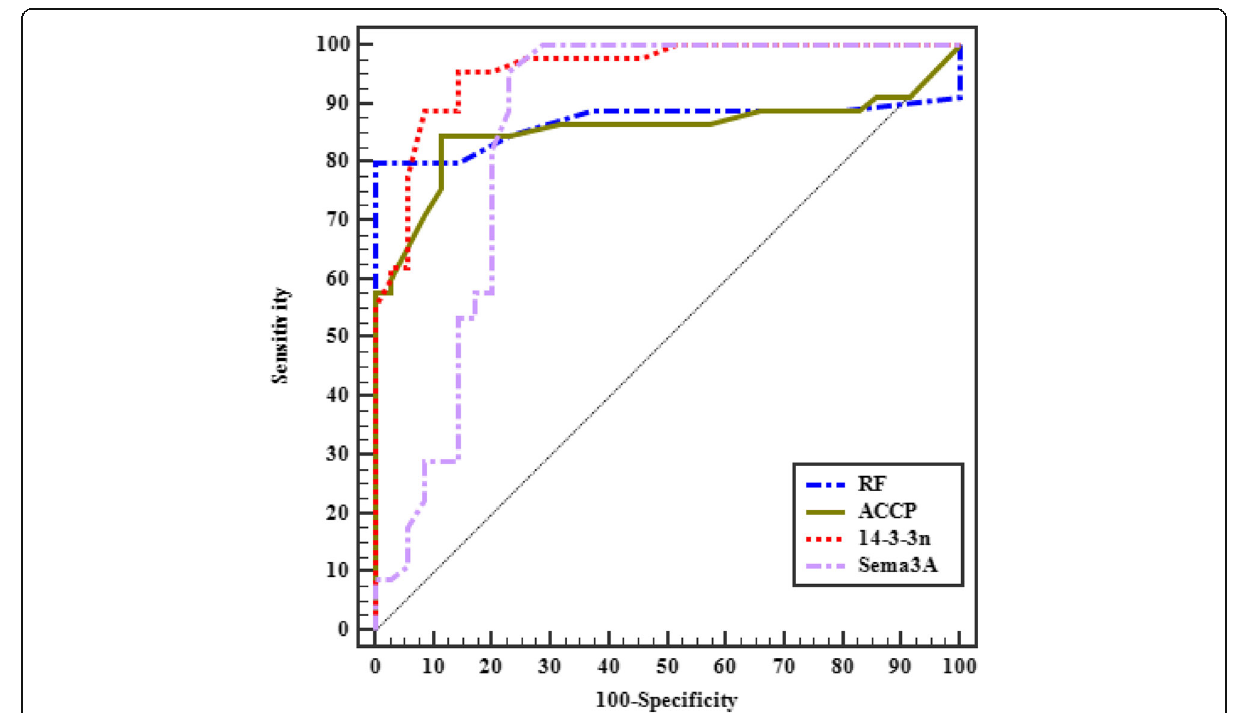
Fig. 1 ROC curve for different parameters to predict cases (vs control). Receiver-operating characteristic curve (ROC) analysis showing that serum Sema3A at a cutoff value of lesser than or equal to 5.8 ng/ml has a sensitivity of 82.82%, a specificity of 80%. AUC (area under the curve) is 0.854